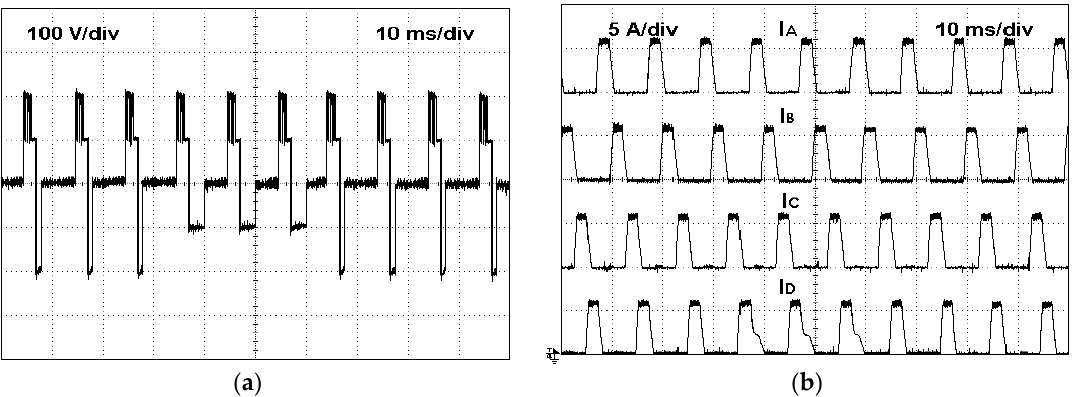
Figure 21. Experimental results of the capacitors voltages when the converter is operating first in normal and then with an open-circuit device fault ( a ) open-switch fault in the semiconductor S 12 ; ( b ) for open-circuit device fault in the semiconductor S 21 .